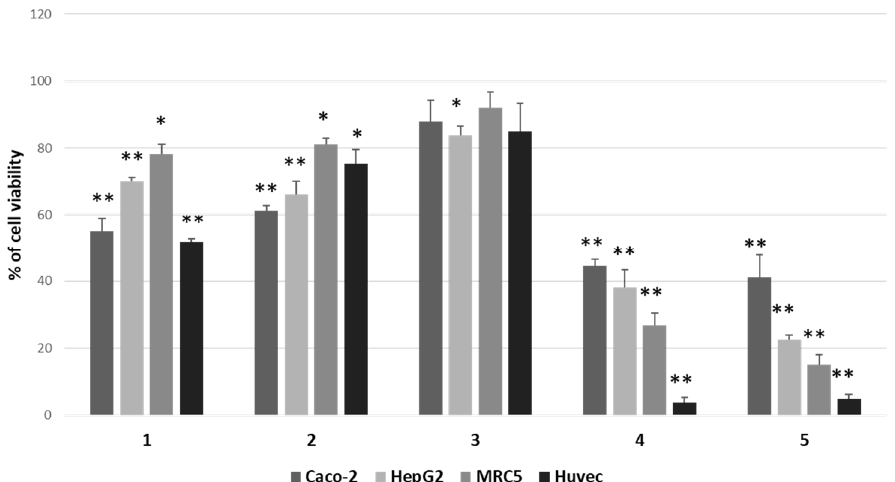
Figure 2. Comparison of cytotoxic effects of P. tomentosa compounds on cancer cell lines (Caco-2 and HepG2), on an immortalised cell line (MRC5) and normal cells (HUVEC). Cells were treated for 24 h with 1 µ M of each compound. Residual viability was measured by the MTT assay. Values are the means ± standard error (SE) of three independent experiments performed in triplicate. Statistical analysis was performed using the Student’s t -test. * p < 0.05 and ** p < 0.01 vs. cells treated with the vehicle (DMSO). In each experiment, DMSO reduced cell viability by not more than 8%.